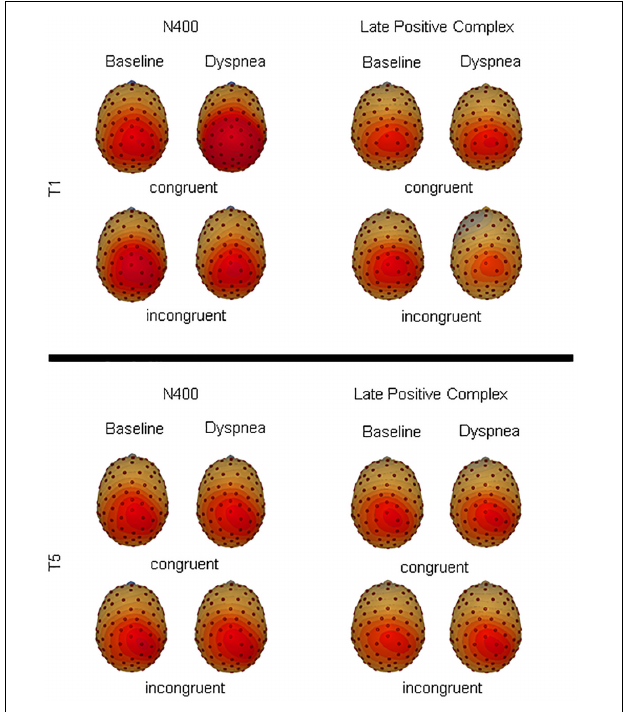
FIGURE 4 | Topographical illustration of the late positive complex and N400 for congruent and incongruent color-words during each condition for T1 and T5.